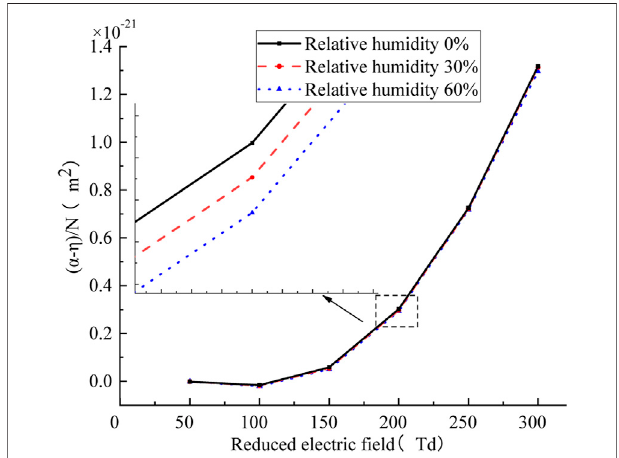
FIGURE 4 | Variation of effective ionization coef fi cient with reduced electric fi eld under different humidity.